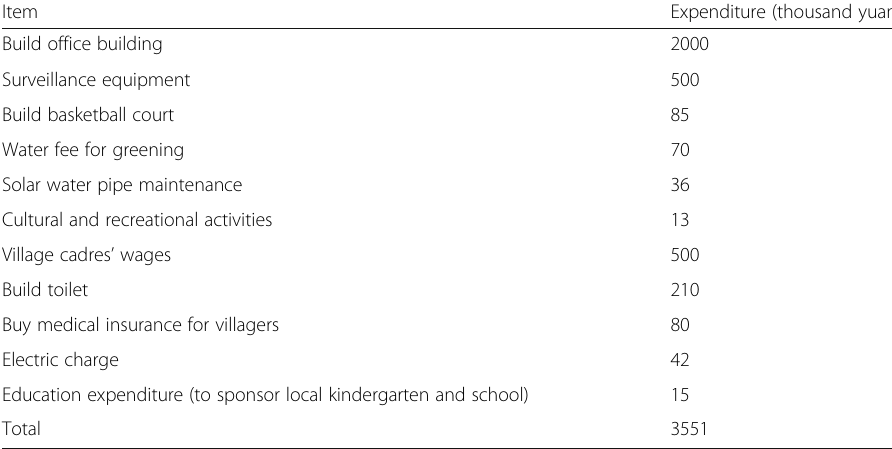
Table 2 Main expenditures for BLM community by Village M in 2012 Item